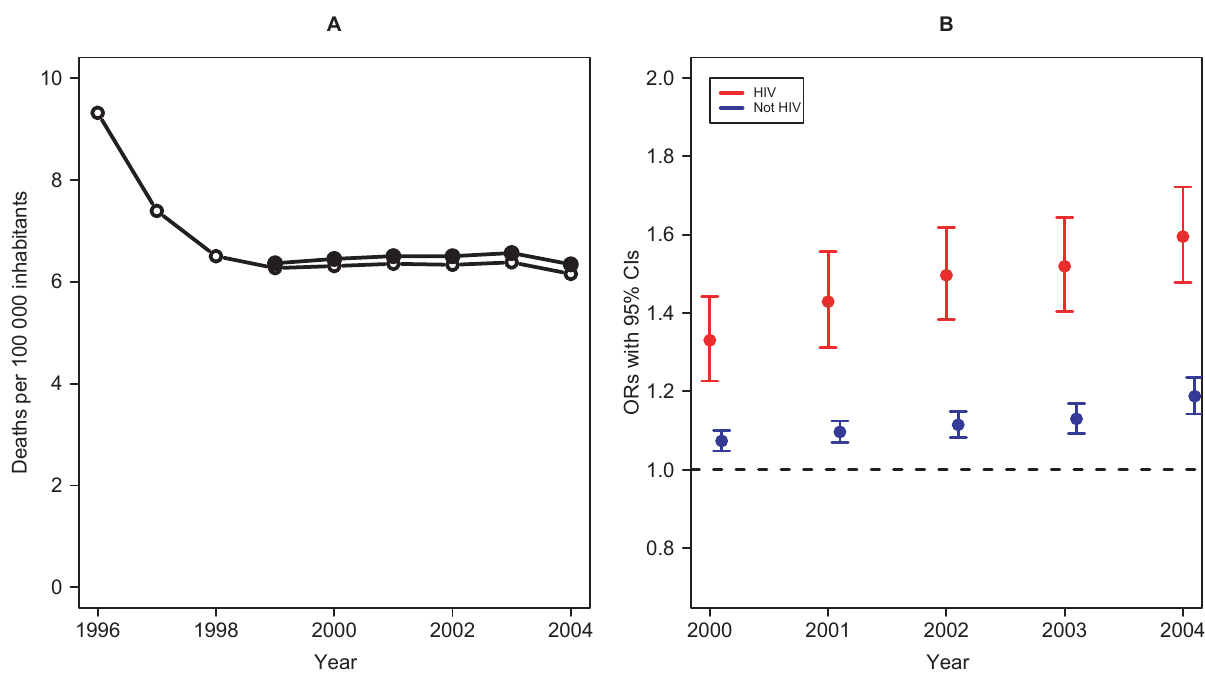
Figure 1. Death Rates and non-HIV-related causes of death. A–Death rates per 100 000 inhabitants of individuals that had HIV/AIDS listed on the death certificate, 1999–2004 (p-value for trend=0.67, solid circles) and AIDS mortality as an underlying disease from 1996 to 2004 (open circles). B– Odds ratios and 95% confidence intervals of non-HIV-related causes of death listed on the death certificate in individuals who had and who did not have HIV listed on the death certificate. Slopes of trends are significantly different between the two groups (p-value , 0.001)